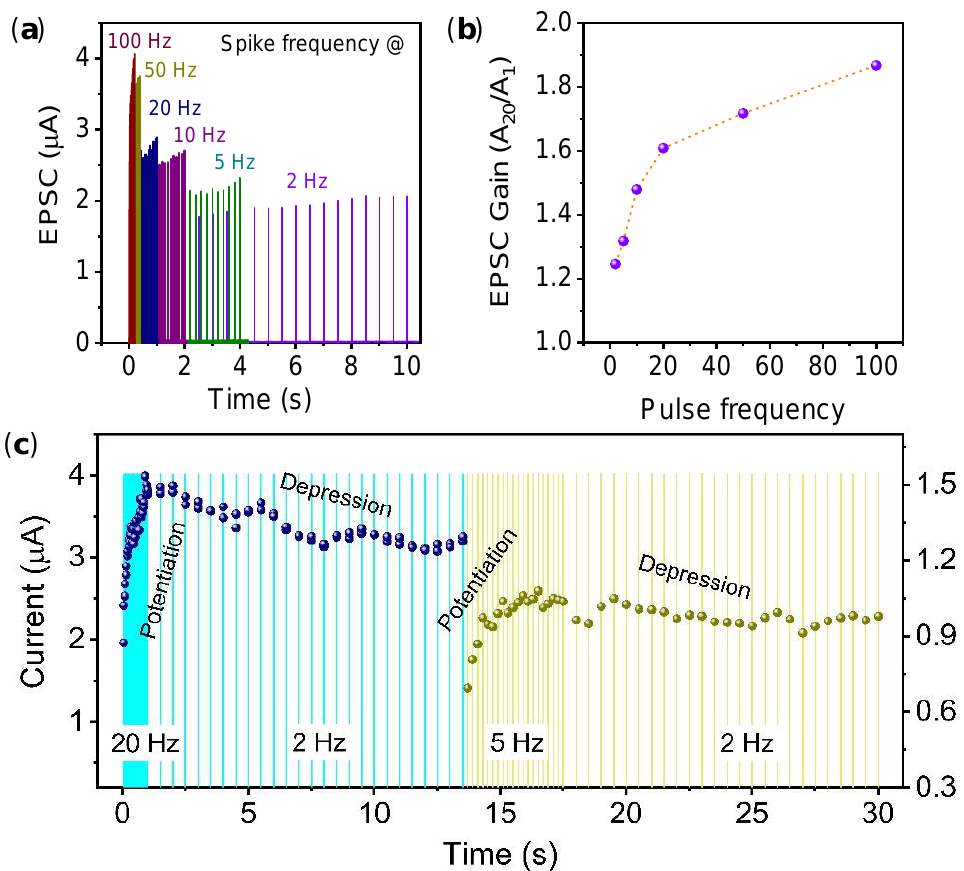
Figure 4. ( a ) Pulse-frequency-dependent current response of the ITO/WO x /TaO x /TiN memristor with trains of 20 pulses at a frequency range of 100 Hz to 2 Hz with an amplitude of +1.5 V/200 µs. ( b ) EPSC gain was obtained as A 20 /A 1 by the pre-synaptic pulse sequence at different frequencies. ( c ) Post-synaptic current response at the same voltage amplitude of +1.5 V/200 µs with decreasing frequency.